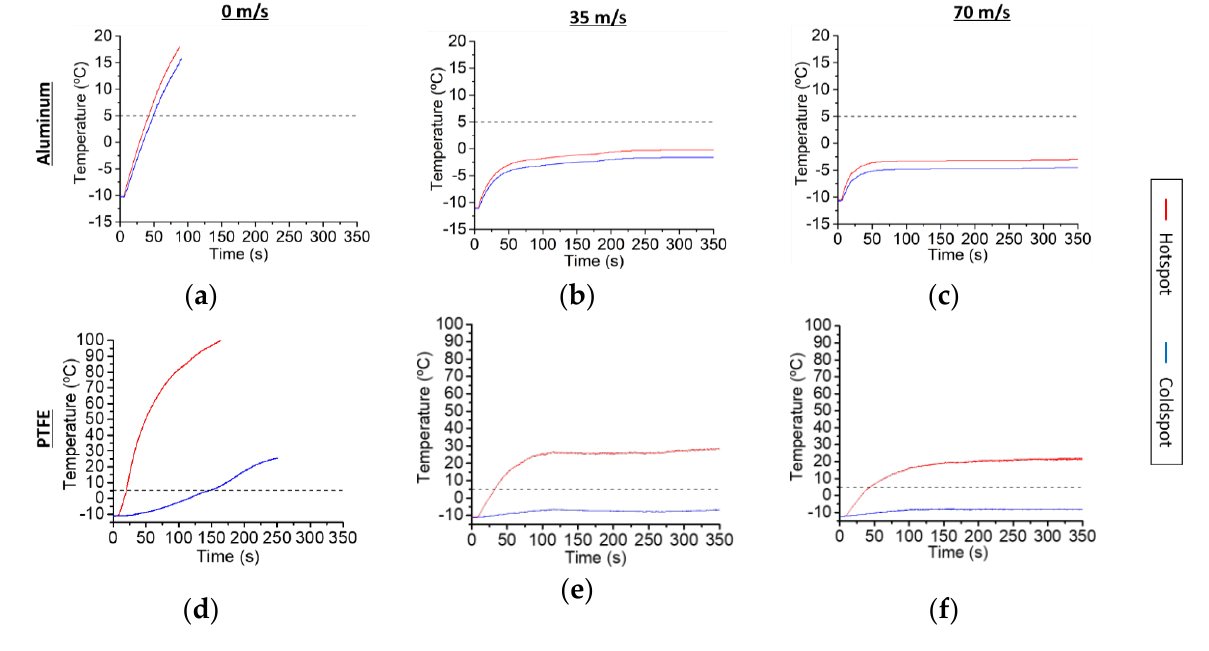
Figure 11. Effect of natural and forced convection in 25 mm × 50 mm samples at 10.9 W; Aluminum at 0 m/s ( a ), 35 m/s ( b ) and 70 m/s ( c ). PTFE at 0 m/s ( d ), 35 m/s ( e ) and 70 m/s ( f ). FEM model results are close to the experimental data under natural convection con- ditions for both AA6061 and PTFE since the goal of modeling is to gain an overall un- derstanding of each parameter’s effect on surface temperature rather than the acquisition of numerical results. In addition, under forced convection, the model seems adequately accurate for the PTFE samples, but as shown in Figure 12, the model diverges from the AA6061 data.